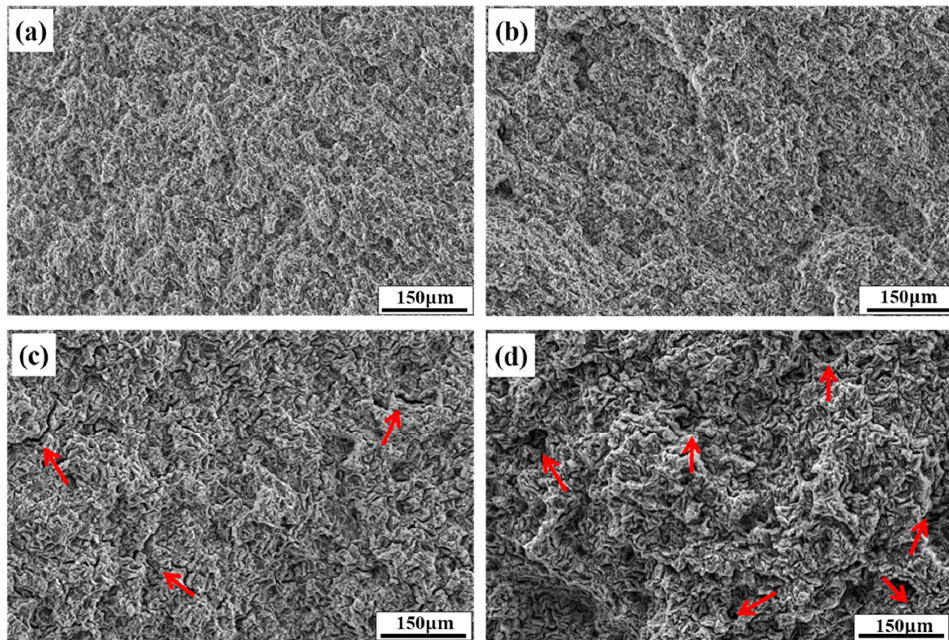
Figure 8. SEM images of the fracture morphology of AZ31 and its composites: ( a ) AZ31, ( b ) 0.5GNPs / AZ31, ( c ) 1.0GNPs / AZ31, and ( d ) 2.0GNPs / AZ31.